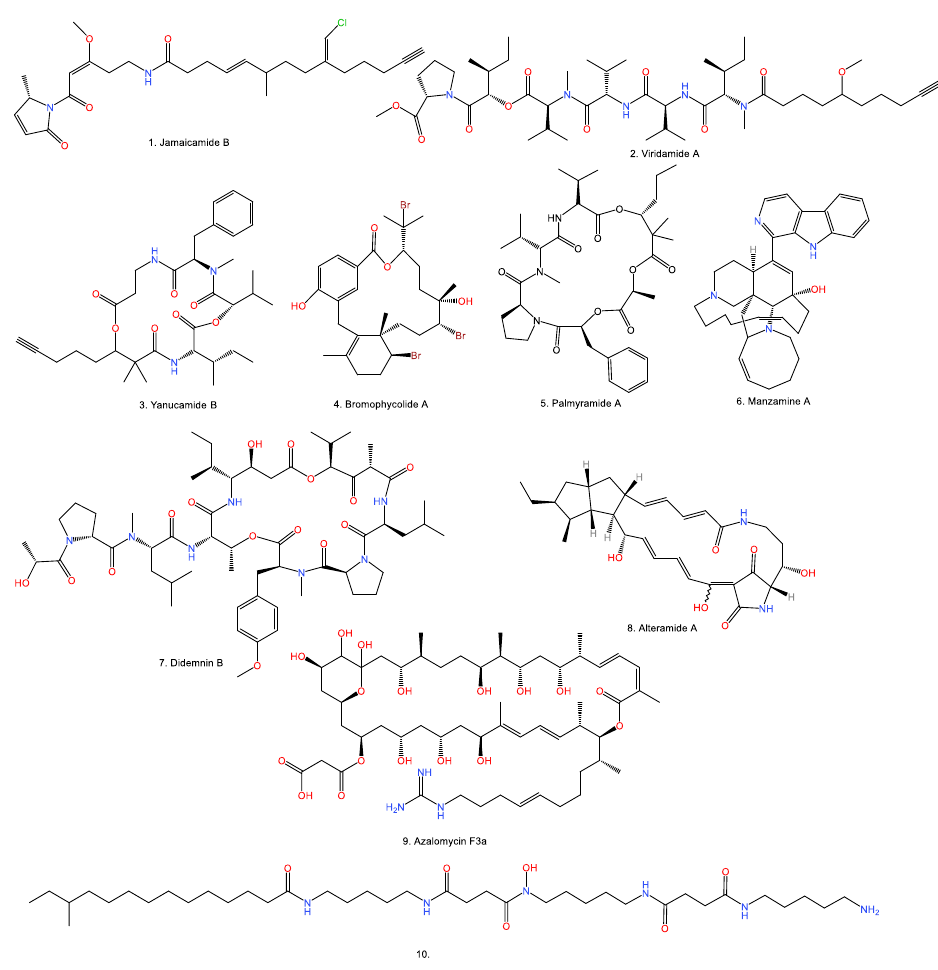
Figure 3. Some observed microbial NPs using MSI.